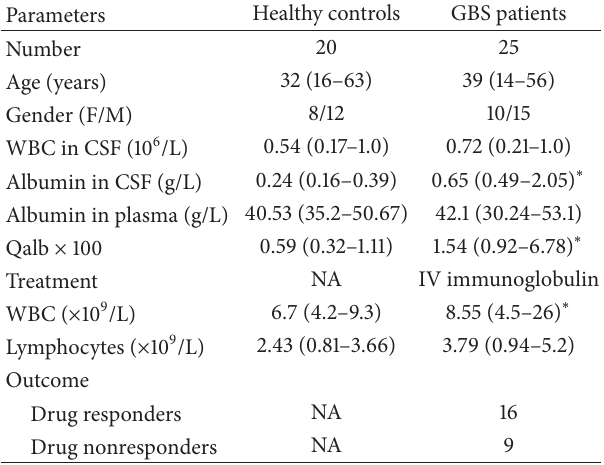
Table 1: The demographic and clinical characteristics of